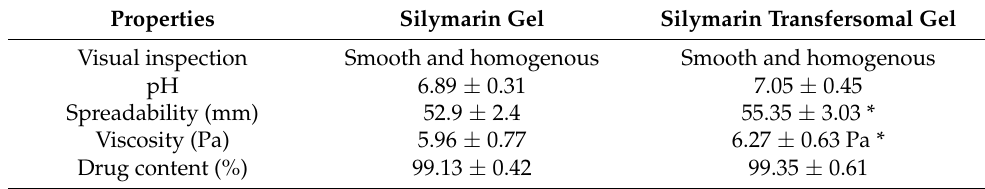
Table 5. Characterization of gel and transfersomal gel formulations encapsulating Silymarin.